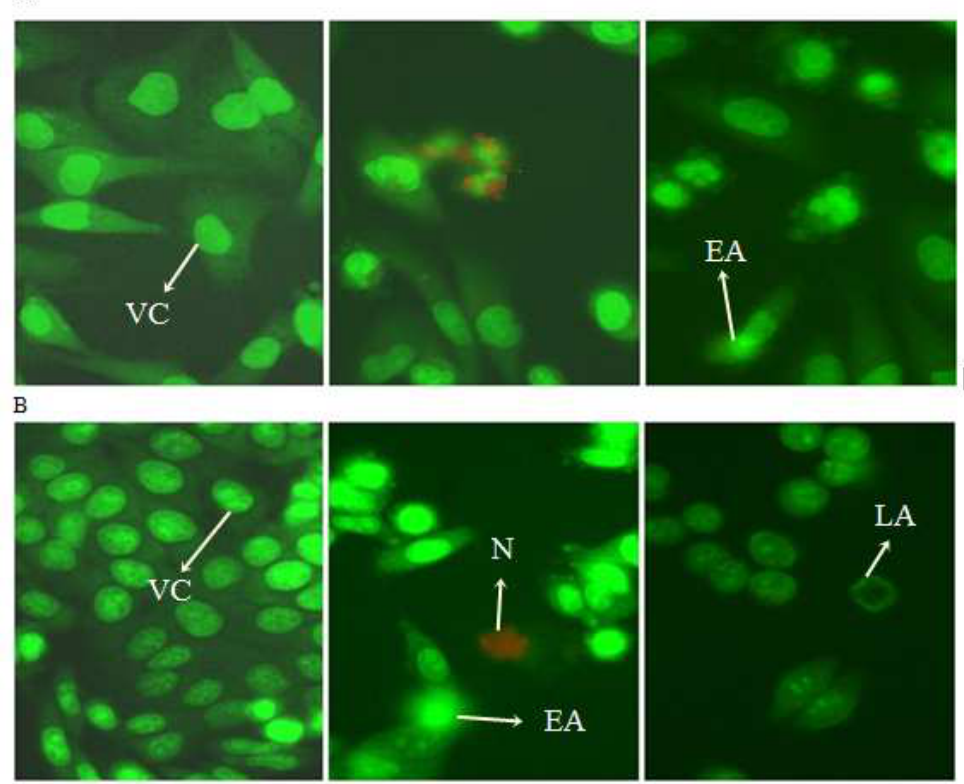
Figure 3. Typical morphological changes (VC–viable cell; EA-early apoptosis; LA-late apoptosis; N- necrosis) of MDA-MB-231 (A) and SW-480 (B) cells induced by T. polium and T. montanum extracts, stained with AO/EB . The images were taken using fluorescence microscopy at